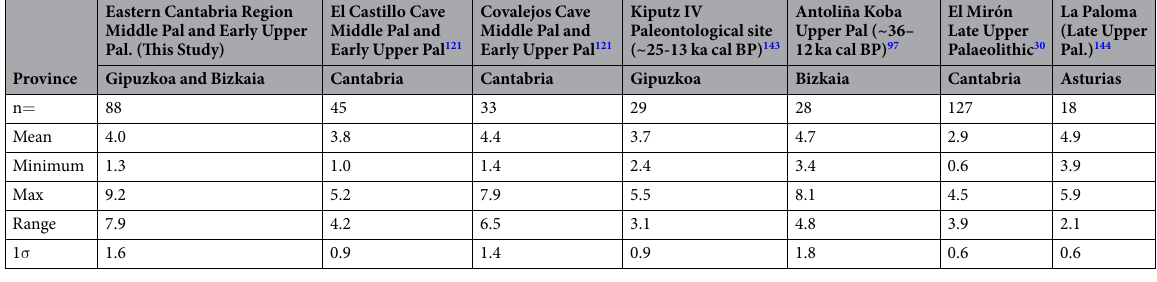
Table 9. Red deer comparisons of mean, minimum, maximum and range δ 15 N values from existing isotopic studies in the Cantabrian Region. No horse specimens were available as a